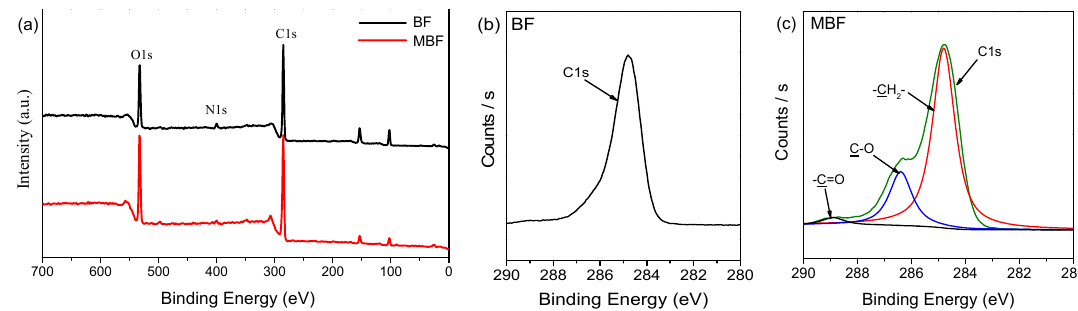
Figure 2. ( a ) X-ray photoelectron spectrometer (XPS) wide scan spectra of basalt fiber (BF) and modified basalt fiber (MBF) with labeled photoelectron (C1s, O1s, and N1s), and XPS high resolutions, C1s spectra of ( b ) BF and ( c ) MBF.